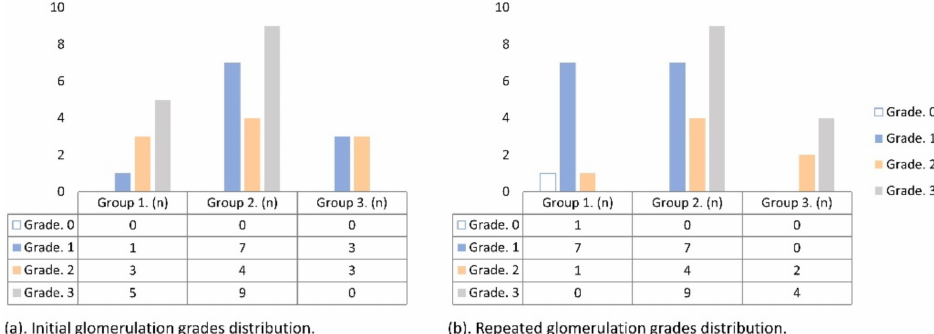
Figure 2. The distribution of glomerulation grades in the initial and follow-up cystoscopic findings in the three groups of patients. ( a ) Distribution of initial glomerulation grades in the three groups. ( b ) Distribution of follow-up glomerulation grades in the three groups.